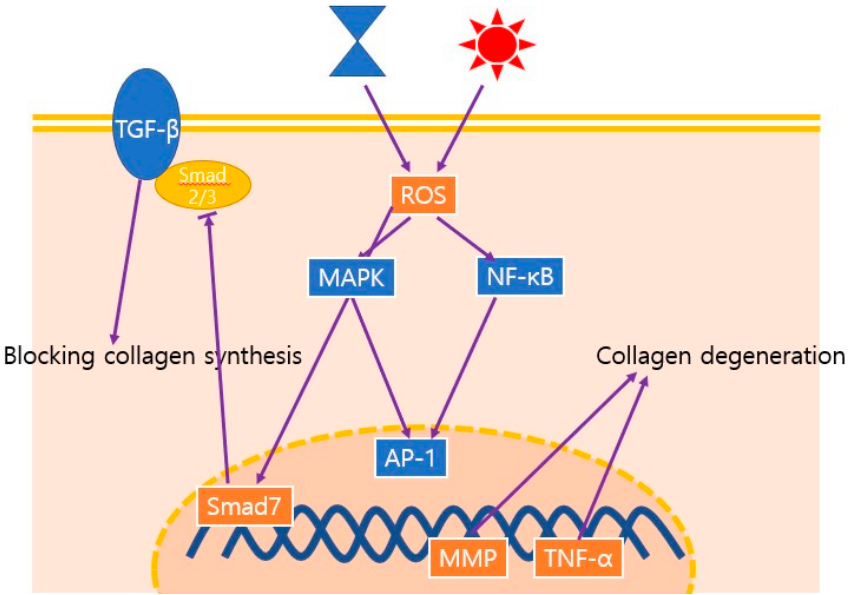
Figure 2. Schematic illustration of the major signaling pathways involved in the aging process; these pathways decrease the density, thickness, and organization of collagen. Both chronological aging and photoaging induce ROS, which leads to the upregulation of MMPs. ROS, reactive oxygen species; MAPK, mitogen-activated protein kinase; NF- κ B, nuclear factor kappa B ; AP-1, activated protein 1; MMP, matrix metalloprotease; TNF- α , tumor necrosis factor- α ; TGF- β , transforming growth factor- β .